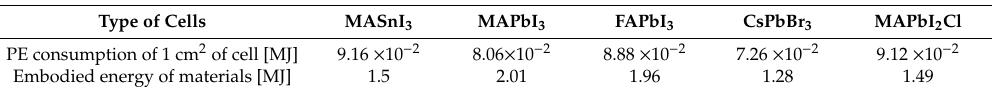
Table 14. Primary energy consumption of perovskite solar cells (1 cm 2 active area) and embodied energy of materials (landfill